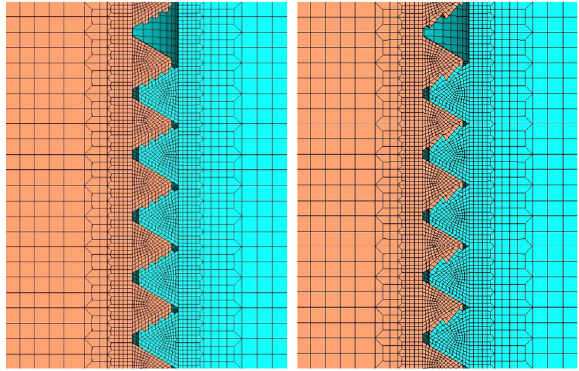
Fig. 16 Two thread connections designed in the previous paper [22]: (a) trapezoidal thread; (b) hook thread.